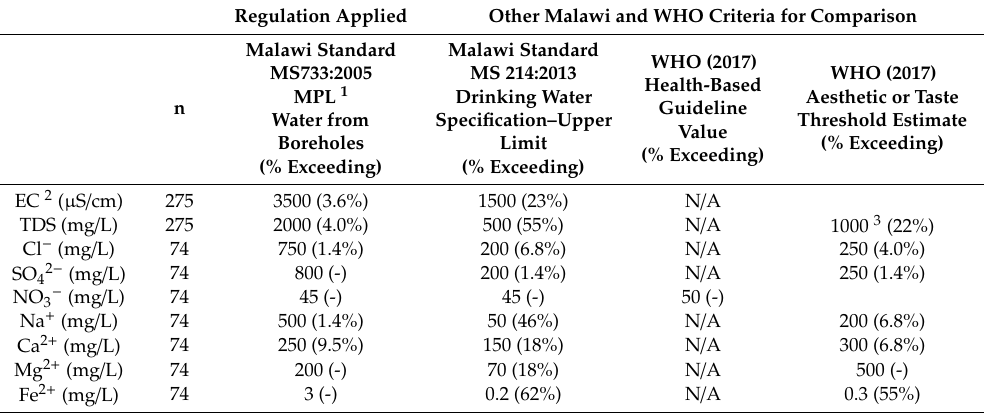
Table 1. Phalombe District 2018 groundwater quality survey summary data compared to water quality standard criteria with percentages of samples exceeding in